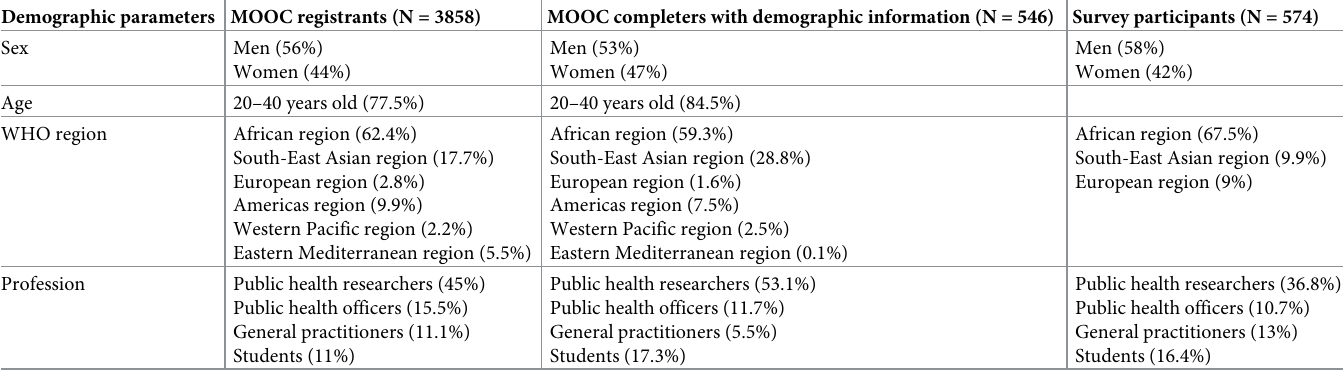
Table 1. A comparison of MOOC participants’, completers’ and survey respondents’ demographic profiles. Demographic parameters MOOC registrants (N = 3858)